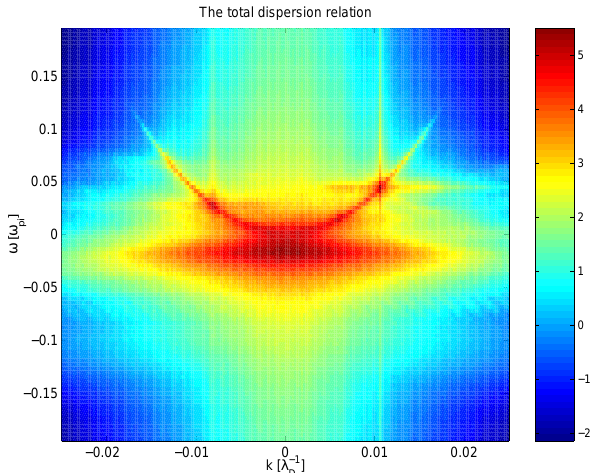
Fig. 4. Power spectral density P ω,k of the electric field vs. wave number and frequency, showing the Langmuir branch ( ω > 0) and the non-propagating oscillations ( ω < 0). Note that E is the field envelope, so the zero frequency in this plot corresponds to ω pe . The color scale is